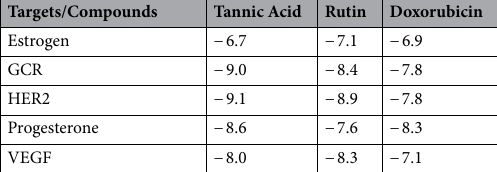
Table 4. Estimated ΔG (Kcal/mol) of HPLC characterized compounds against cervical cancer targets.